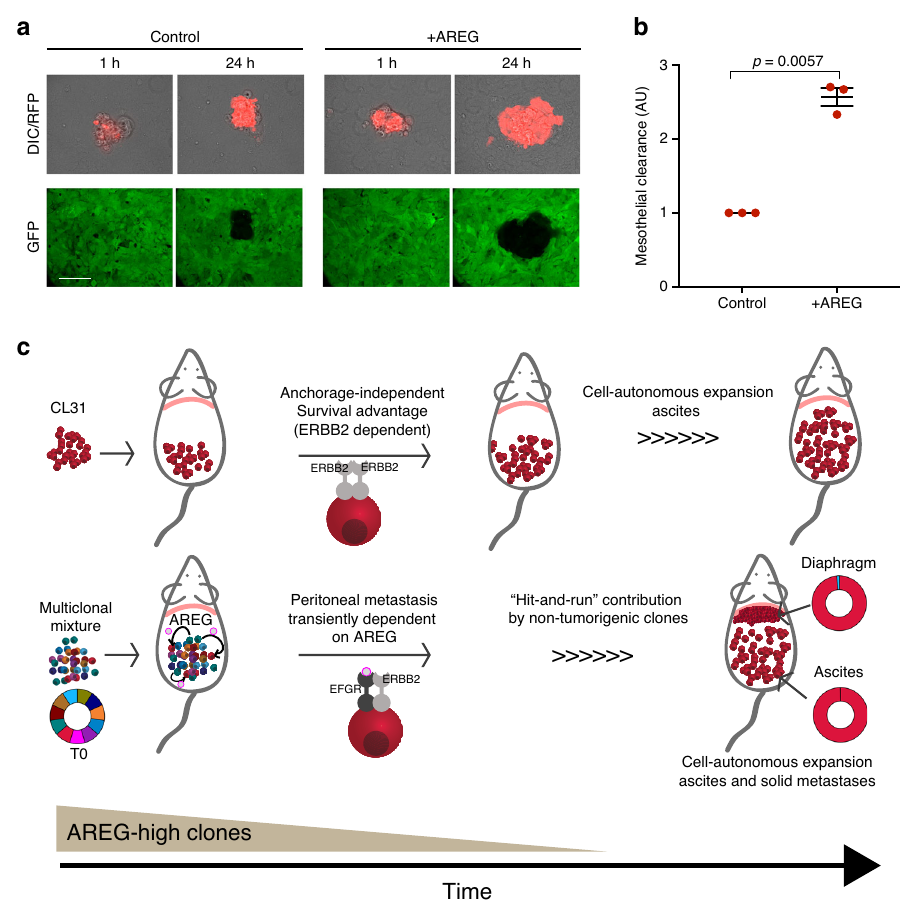
Fig. 7 AREG enhances mesothelial clearance ability of CL31. a Representative differential interference contrast (DIC) and pseudocolored confocal fl uorescence images of ability of vehicle- or AREG-treated CL31 cell clusters expressing red fl uorescent protein (RFP) to clear a mesothelial monolayer expressing green fl uorescent protein (GFP) at the indicated time points. Scale bar, 50 μ m. b Quanti fi cation of the mesothelial clearance area (black area within the green monolayer) cleared in 24 h by CL31 spheroids treated with vehicle or AREG from three independent experiments. Mesothelial area cleared at the end point was normalized to the initial (1 h) area of CL31 clusters (measured from the DIC images), as previously described 39 . Relative clearance area of 20 – 30 clusters of CL31 of each condition per experiment were analyzed and averaged. Data shown as mean ± SEM of three independent experiments, shown in arbitrary units (AU), p value from Welch ’ s t test of the means. c Model illustrating the transient cooperative interactions involved in metastasis in this model system. CL31, which carries ampli fi ed ERBB2 and displays anchorage-independent growth in vitro, forms only malignant ascites, but is unable to form solid peritoneal metastasis. Transient and non-tumorigenic AREG-high clones can act at an early temporal window, and are later dispensable, to induce CL31 solid peritoneal metastasis. AREG is required for metastasis of CL31, but not expansion in ascites or metastatic sites.